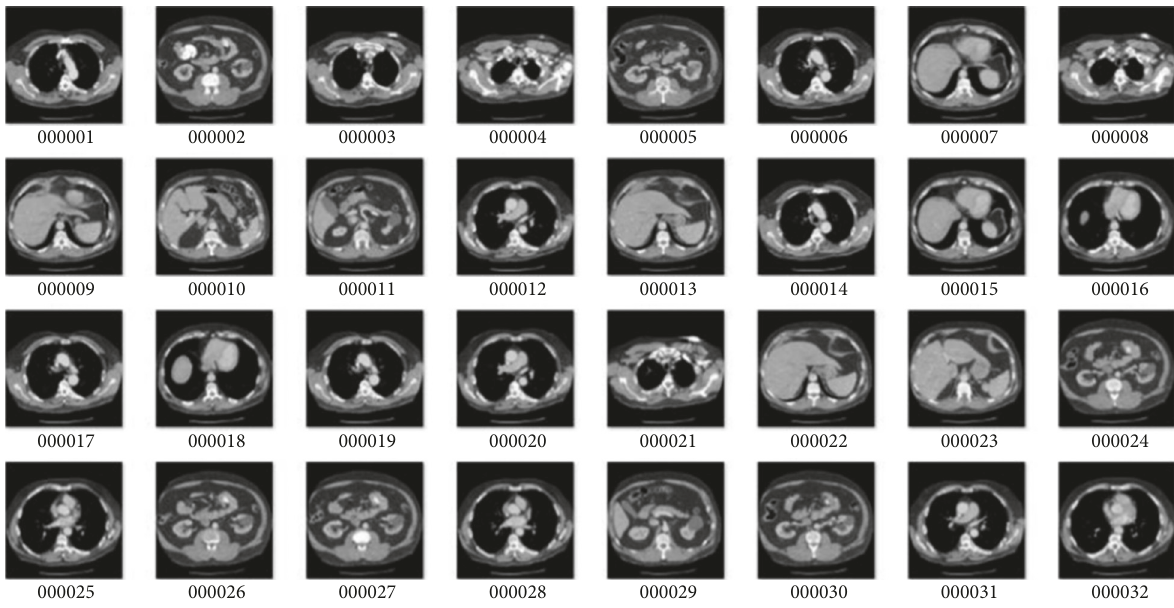
Figure 9: CT scan images for CNN training